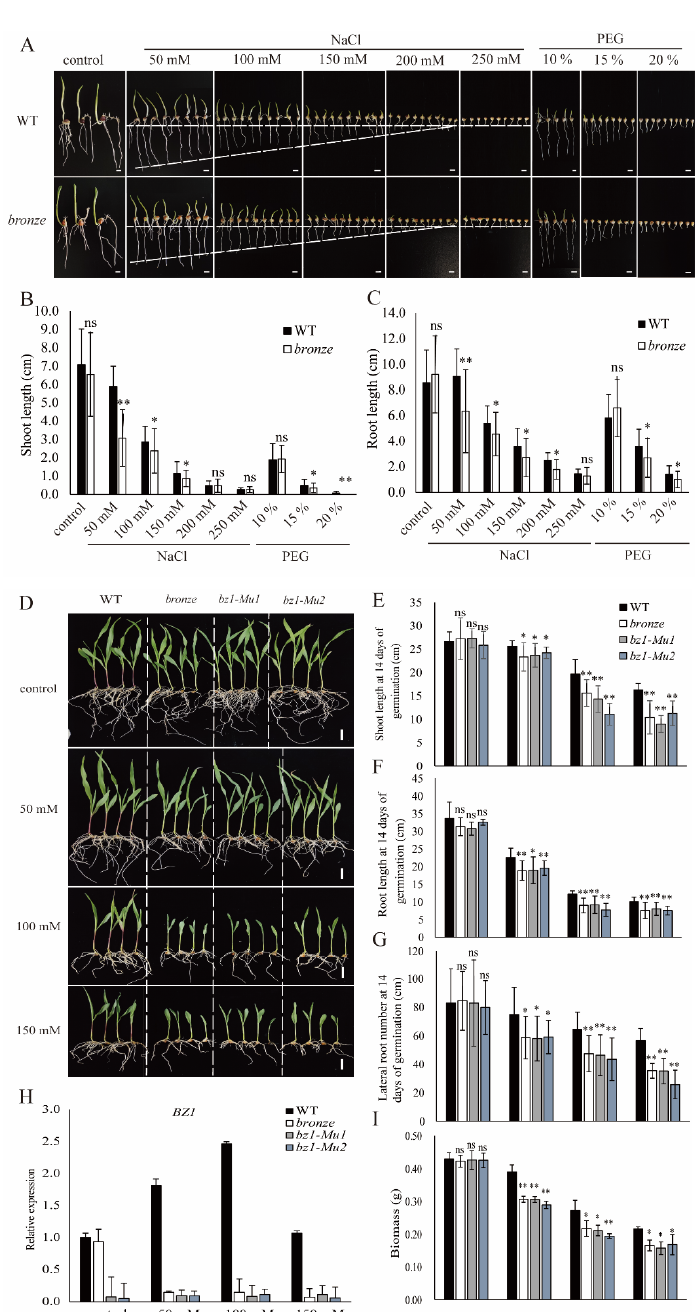
Figure 5. Roles of ZmBZ1 in abiotic stresses tolerance. ( A – C ) Simulation of salinity and drought stresses with 50 mM, 100 mM, 150 mM, 200 mM and 250 mM NaCl solutions, and 10 %, 15 %, 20 % PEG solutions, respectively ( A ). The comparison of WT and bronze to abiotic stresses was evaluated by measuring the shoot length ( B ) and root length ( C ) of the seedlings germinated for 7 days. Asterisks indicate significant differences relative to the WT (Student’s t -test: * p < 0.05; ** p < 0.01; ns means no significant difference); ( D – I ) Salinity stress treatment of WT and three Bz1 alleles by treated with 50 mM, 100 mM and 150 mM NaCl solution for 14 DAS in sands ( D ), shoot length ( E ), primary root length ( F ), number of lateral roots ( G ) and biomass ( I ) of the above seedlings. qPCR analysis of ZmBZ1 expression in different degree of salinity stress ( H ). Asterisks indicate significant differences relative to non-treatment (Student’s t -test: * p < 0.05; ** p < 0.01; ns means no significant